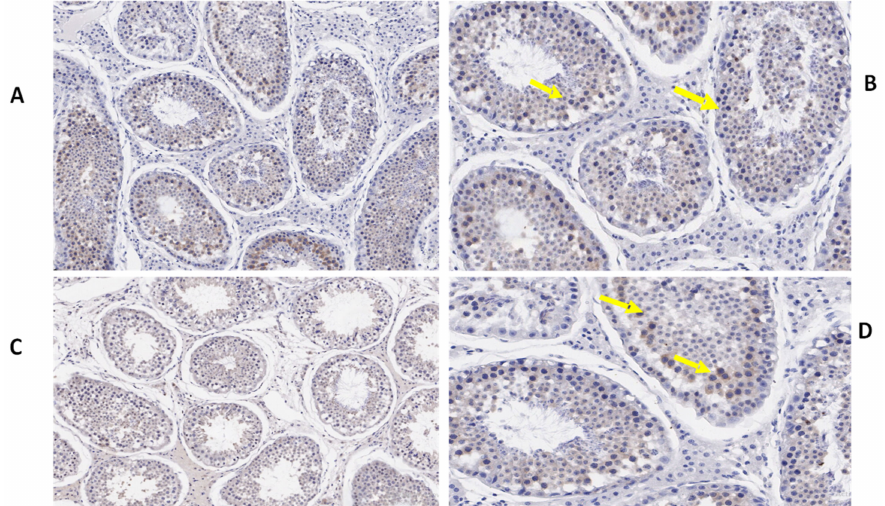
Figure 5. Immunohistochemical localization of ESR α protein in the testes of yaks under different feeding conditions. Immunohistomestry indicated that TEX11 protein was present in both groups but positive cells (yellow arrow) were more prominent in the tubules of the concentrate supplementation group as compared to the group without concentrate supplementation: ( A , B ) natural grazing plus concentrate supplementation; ( C , D ) natural grazing without concentrate supplementation. Scale bar = 50 µ m ( A – D ).